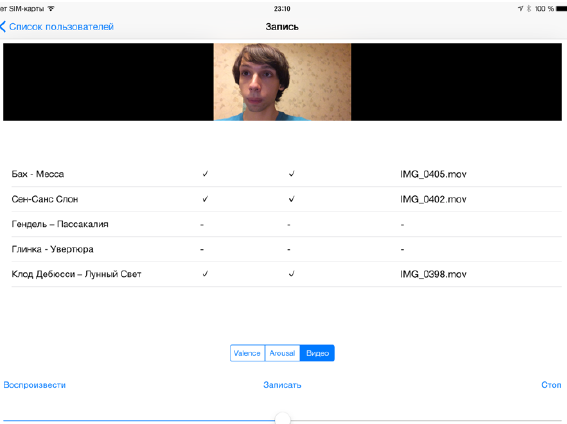
Figure 3. ‘EmotionGrabber’ software user